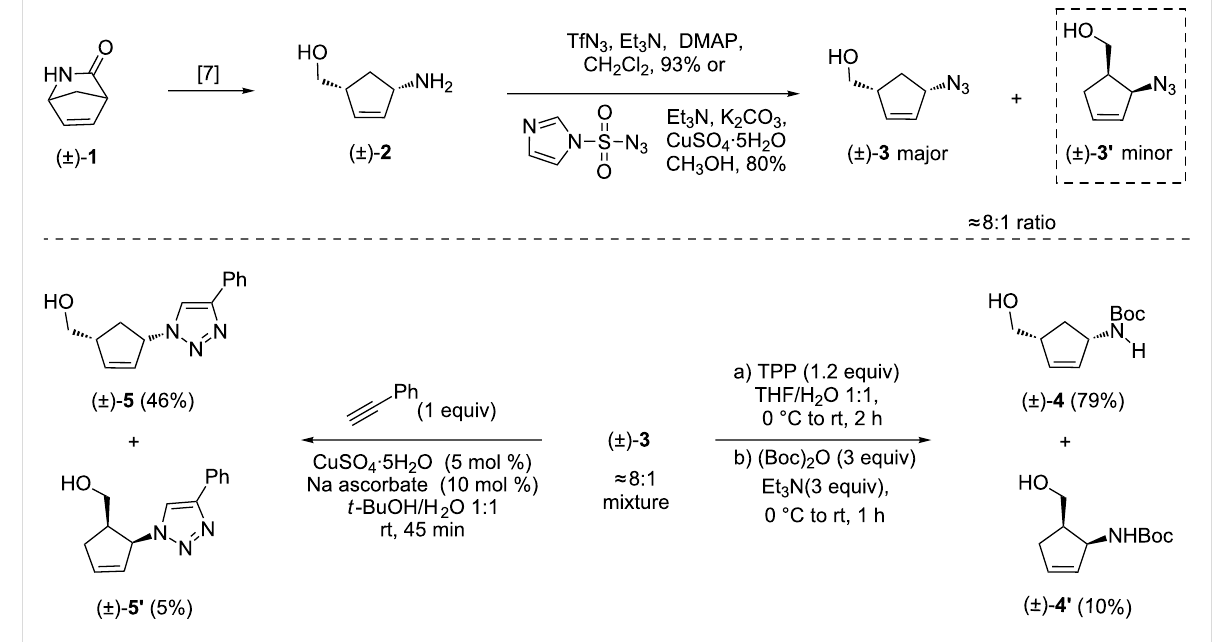
Scheme 2: Top: synthesis of azido alcohol derivative 3 and bottom: structural elucidation of the minor diastereomer.